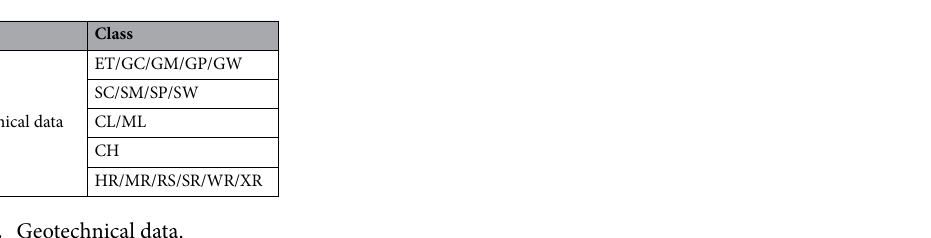
Table 1. Geotechnical